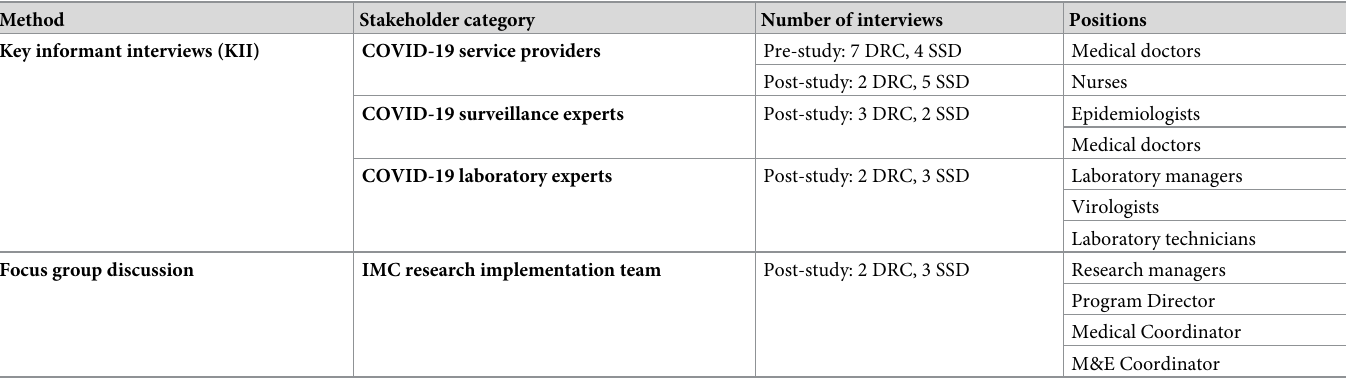
Table 1. Summary of data collection and respondent